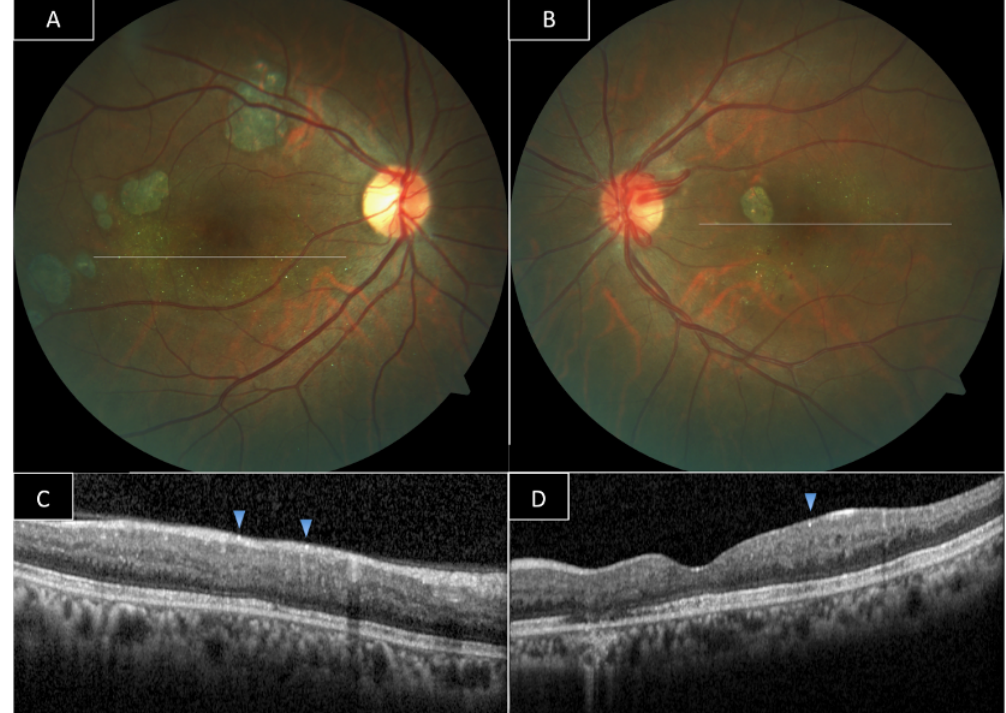
Figure 2: Color fundus photography (Eleven years after initial presentation): retinal crystals surrounding the fovea bilaterally (A, B). Optical coherence tomography (single horizontal linear scan): punctate hyperreflectivity in near all retinal layers. Retinal crystals are corresponding to superficial hyperreflective spots (C,